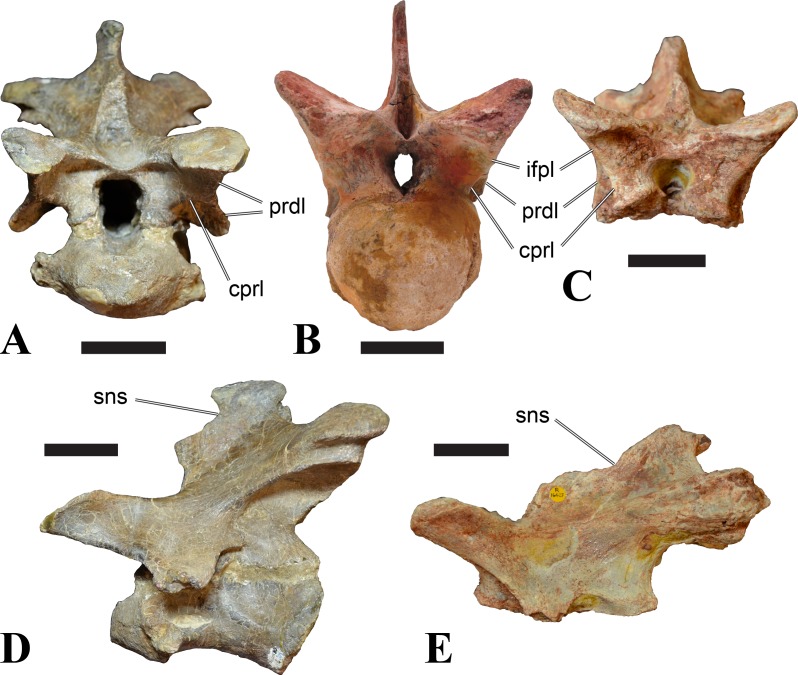
Comparison between mid-cervical vertebrae of Baryonyx and Sigilmassasaurus.(A) Ce4 of Baryonyx in anterior view; (B) CMN 50791, Sigilmassasaurus mid-cervical vertebra (Ce6-7); (C) NHMUK PV 16427 Sigilmassasaurus mid-cervical (?Ce4) in anterior view; (D) Ce4 of Baryonyx in left lateral view; (E) NHMUK PV 17427 Sigilmassasaurus in left lateral view. Abbreviations: cprl, centroprezygapophyseal lamina; ifpl, infraprezygapophyseal lamina; prdl, prezygodiapophyseal lamina; sns, stepped neural spine. Scale bars equal 5 cm.